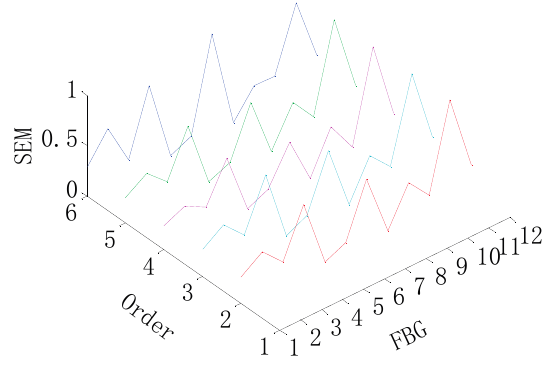
Figure 10. SEM for the single-damage detection.